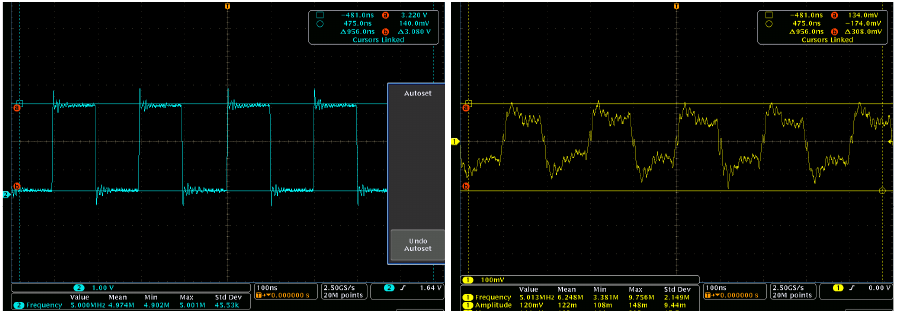
Figure 3. Transmitted and received signal.